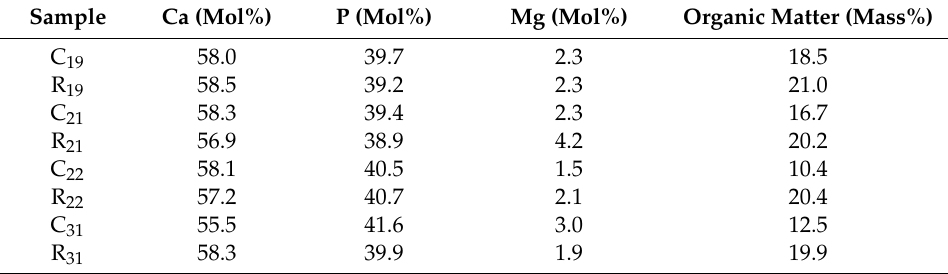
Table 1. Summary of ICP-MS and TGA data for selected human dentin samples.